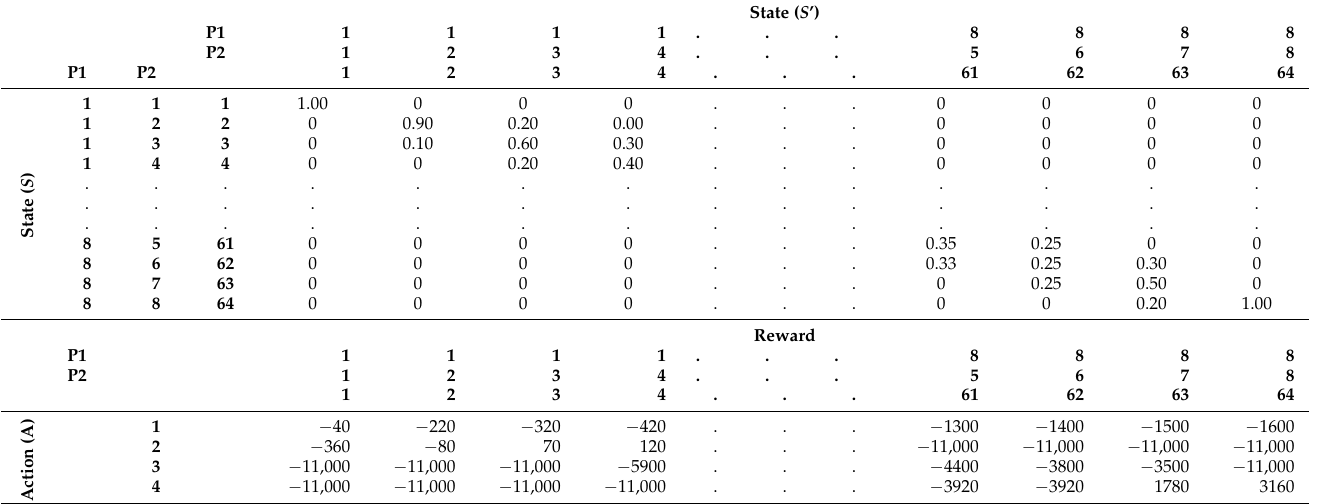
. . . 1.00 The observations and reward functions have been calculated by multiplying the respective state’s values. Table 7 gives the observation probabilities for the overlapping case of the model’s formulation and the cost of taking a given action under a specific state. Table 7. Observation probability (overlapping case) and reward for a two-pipe system based on pipeline 1 (P1) and pipeline 2 (P2). State ( S ’) P1